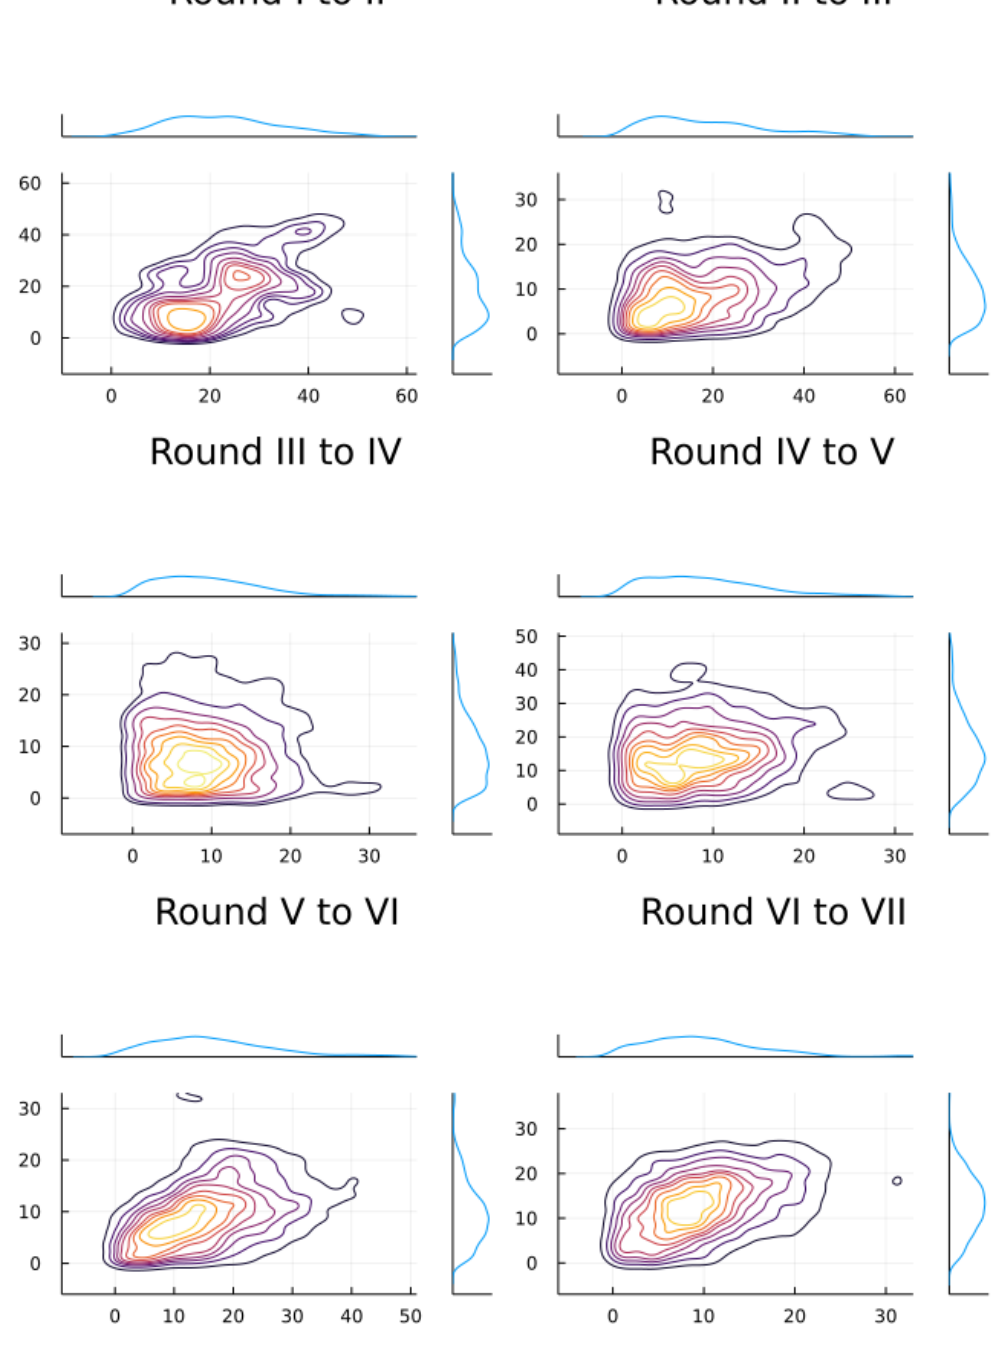
Figure A1. Game results N =